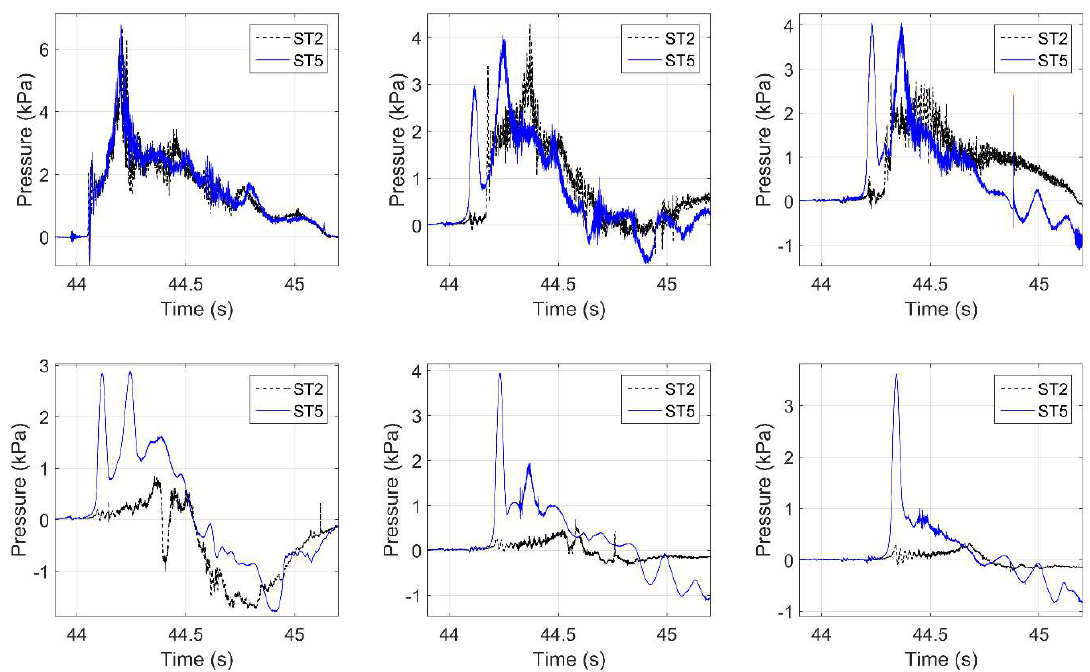
Figure 6. Applied wave pressures on the offshore side of girders ( top ) G1 ( left ), G2 ( middle ), and G3 ( right ); and below the deck ( bottom ) in chambers Ch1 ( left ), Ch2 ( middle ), and Ch3 ( right ) for a solitary wave with H = 0.42 m and two deck types